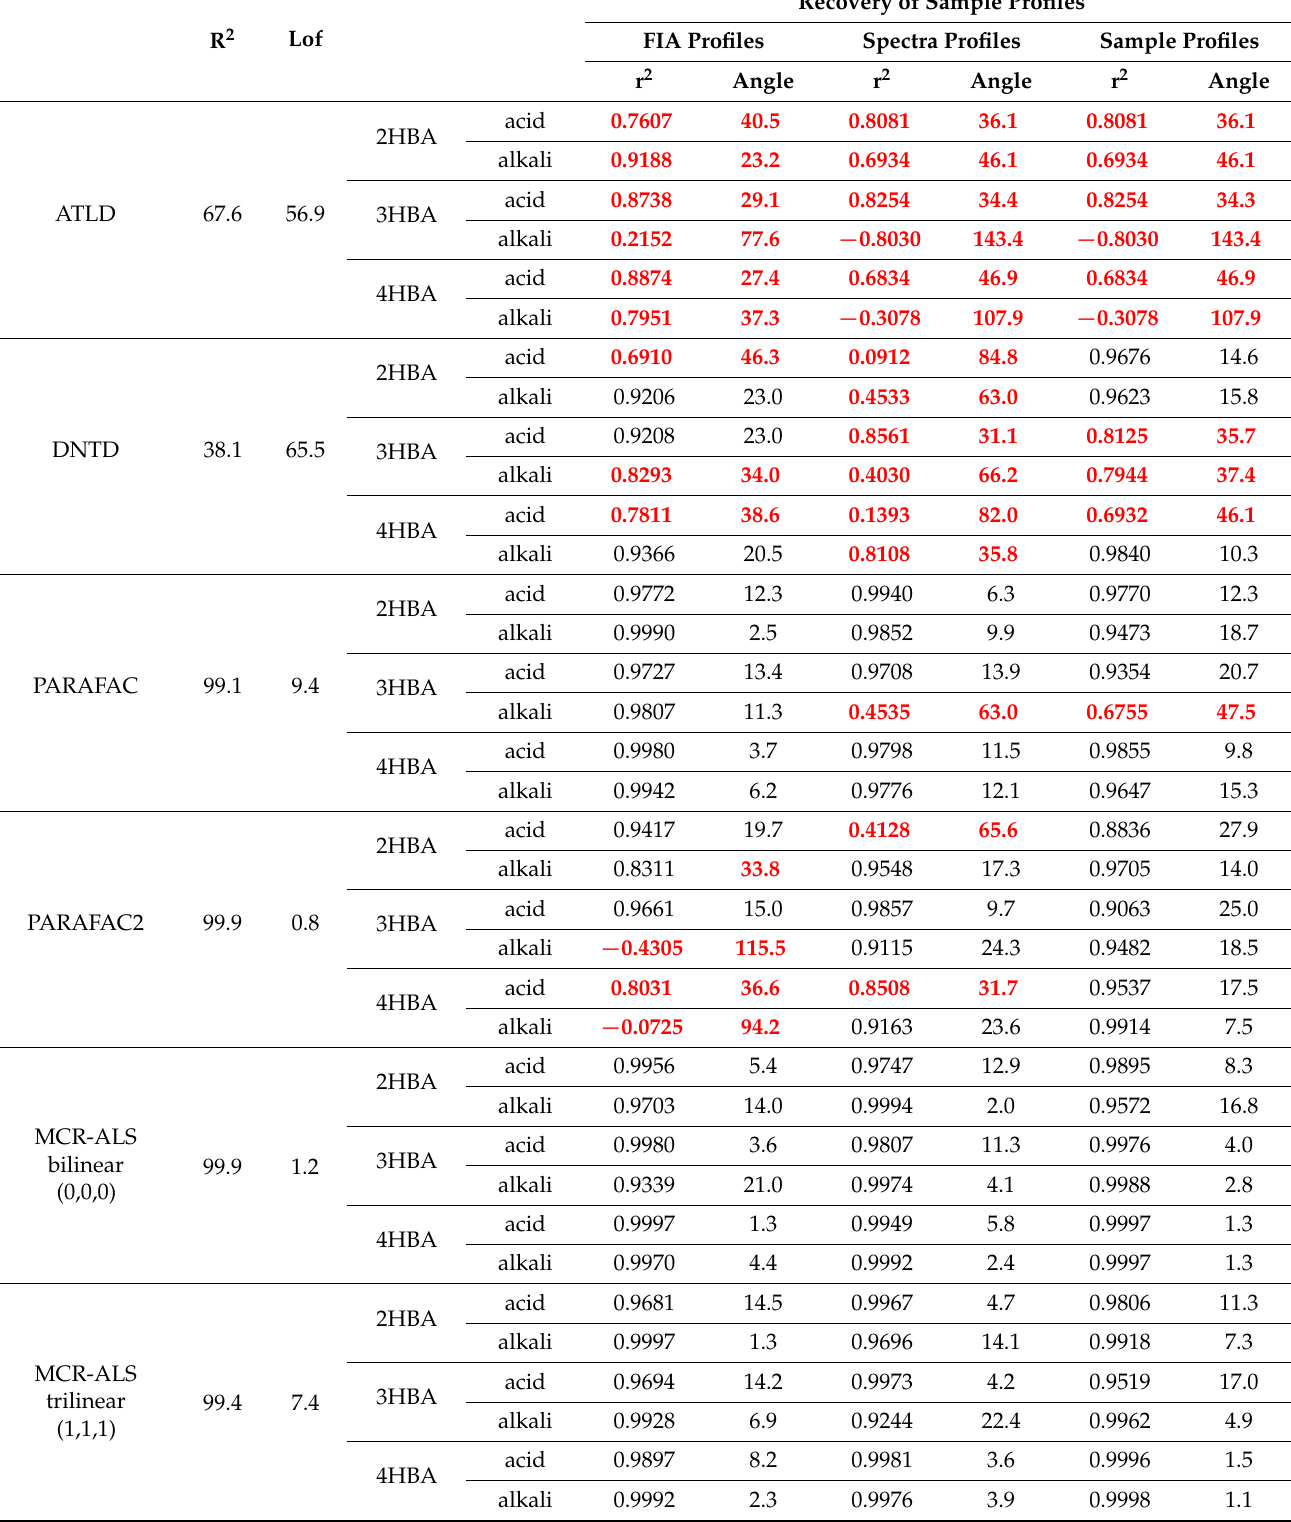
Table 3. Comparison of results obtained by ATLD, PARAFAC, PARAFAC2, and different variants of MCR-ALS using six components in the analysis of the FIA dataset. In bold red, the worse recovered profiles with r 2 values below 0.9 are shown. See Equations (7)–(10) for the meaning of R 2 , lof, r 2 and angle. See end of Section 2.2 for the meaning of the different MCR-ALS